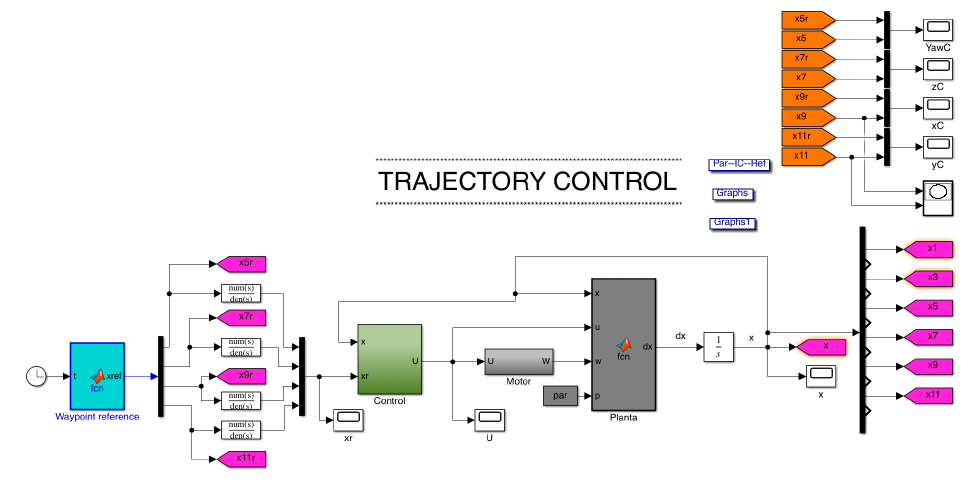
Figure 6. Quadrotor mathematical model in Simulink.